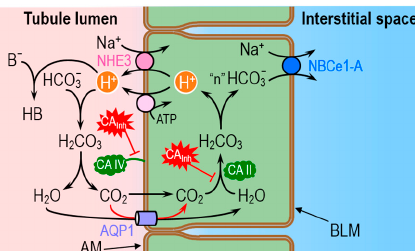
Figure 7. Classical model of HCO 3 − reabsorption and titration of non-CO 2 / HCO 3 − luminal weak bases by the renal proximal tubule (PT). According to the classical view, the only acid–base transporters at the apical membrane (i.e., the membrane facing the tubule lumen) are the Na-H exchanger NHE3 and the vacuolar-type H + pump. The energy for Na-H exchange comes from the inward Na + gradient, established by the Na-K pump on the basolateral membrane (not shown), and the energy for the apical H + pump comes from ATP hydrolysis. HCO 3 − reabsorption (or reclamation) occurs when the H + secreted in the tubule lumen rapidly combines with HCO 3 − (previously filtered in the glomerulus) to form H 2 CO 3 , which slowly dissociates to form H 2 O and CO 2 . Although the figure shows the GPI-linked enzyme carbonic anhydrase (CA) IV as catalyzing the slow dehydration of H 2 CO 3 , in fact CA IV bypasses this slow step by catalyzing the direct conversion of HCO 3 − and H + to H 2 O and CO 2 . The CO 2 and H 2 O newly formed in the lumen then di ff use into the PT cytosol, mostly through the channel aquaporin AQP1. In the cytosol, although the figure shows cytosolic CA II catalyzing the slow hydration of CO 2 to form H 2 CO 3 , in fact, the CA II directly converts CO 2 and H 2 O to H + and HCO 3 − . The H + recycles back into the lumen. The HCO 3 − exits the PT cell across the basolateral (i.e., blood-side) membrane via the electrogenic Na / HCO 3 cotransporter, which exports the equivalent of 2 or 3 HCO 3 − ions with 1 Na + ion. The process just described merely reclaims previously filtered HCO 3 − ; it does not titrate any acids in the body. A second fate of the H + secreted in the lumen can be its combination with luminal NH 3 —which the PT cell generates from glutamine and glutamate—to form NH 4 + , most of which appears in the urine. This process is termed ammonium secretion. A third fate of the secreted H + is to titrate weak bases other than HCO 3 − or NH 3 (e.g., phosphate, creatinine) to form the conjugate weak acid. The amount of such acid is termed the titratable acidity. In the figure, we show all of these non-HCO 3 − titrations as the idealized reaction B − + H + → HB. Of course, B can have any valence (e.g., 0 in the case of NH 3 ), and HB has a valence 1 greater than that of B ( + 1 in the case of NH 4 + ). A fourth and final fate of the secreted H + is to remain unbu ff ered and thereby lower the pH of the tubule fluid. Whether the secreted H + titrates NH 3 or another non-CO 2 / HCO 3 − bu ff er, or remains unbu ff ered, one “new HCO 3 − ” moves via NBCe1-A into the interstitial space to titrate acids